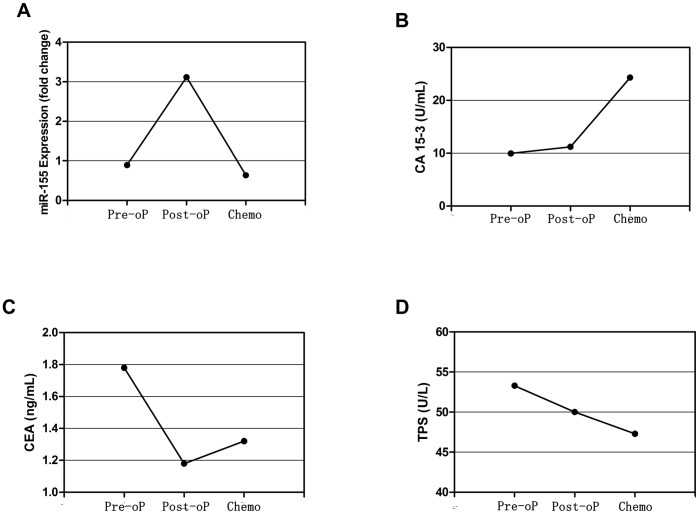
Changes in serum levels of miR-155, CA 15-3, CEA, and TPS in the patient who experienced relapse before (Pre-oP) and after surgery (Post-oP), and after chemotherapy (Chemo).The level of miR-155 underwent a 250% increase after surgery, and decreased to the preoperative level after chemotherapy (A). In light of a change in the serum marker levels ≥25% was regarded as a significant alteration, the level of CA 15-3 did not change after surgery but significantly elevated after chemotherapy (B); the level of CEA decreased after surgery (C); the level of TPS did not change (D).